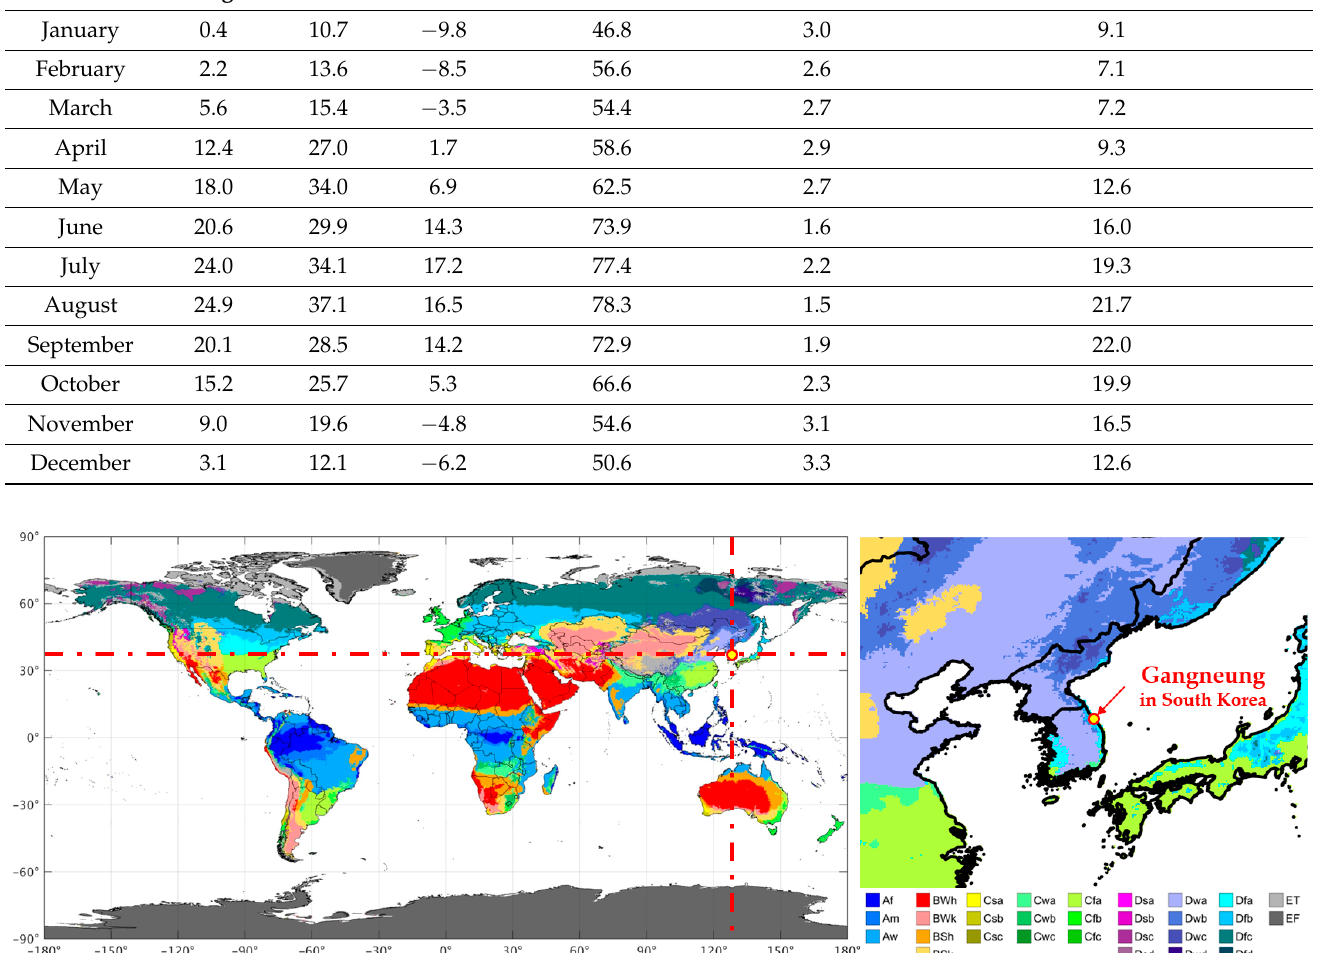
Table 4. Weather data used in the simulation model.